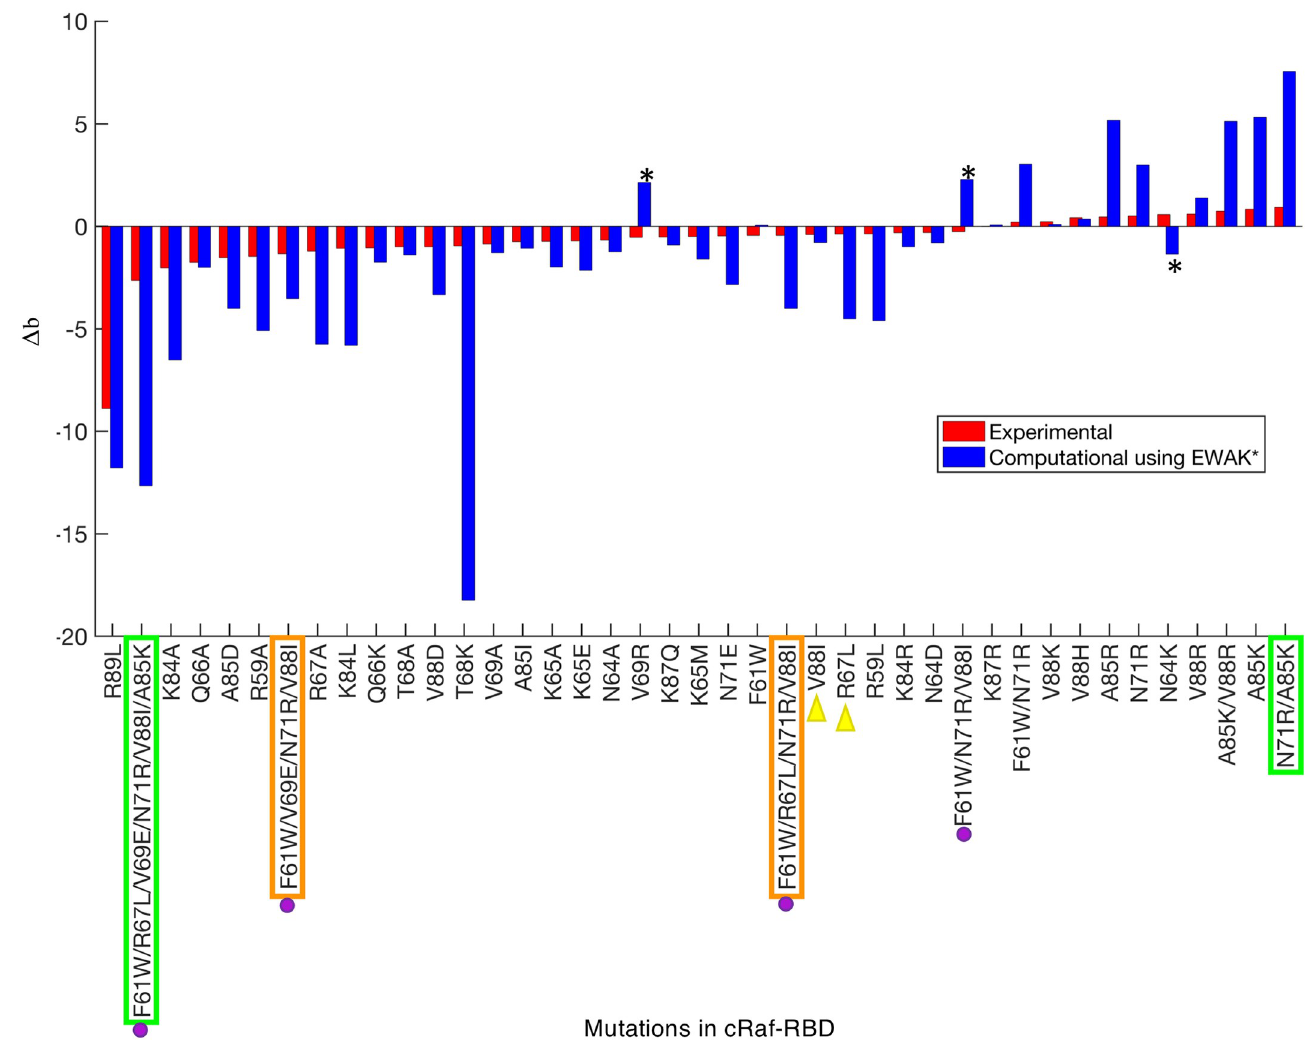
Fig 5. Predicting the effect of mutations in c-Raf-RBD on binding with KRas. Each bar represents either the experimental (red) or computationally predicted (blue) effect each variant has on binding. The bars are sorted in increasing order of Δ b value (see the Section entitled “ FRIES / EWAK � retrospectively predicted the effect mutations in c-Raf-RBD have on binding to KRas”) of the experimental (red) bars. If the Δ b value is less than 0, binding decreases. If the Δ b value is greater than 0, binding increases. If the Δ b value is close to 0, the effect is neutral. Quantitative values of K � tend to overestimate the biological effects of mutations (leading to the much larger blue bars) due to the limited nature of the input model compared to a biologically accurate representation. However, K � in general does a good job ranking variants, as can be seen here in Fig 6, in [1], and in [38]. Out of the 41 variants listed on the x -axis, only 3 were predicted incorrectly (marked with black asterisks) by EWAK � . In terms of accuracy, BBK � performed very similarly to EWAK � , however, in 2 cases (marked with green boxes), BBK � ran out of memory and was unable to calculate a score. BBK � also did not return values for the 2 variants marked with orange boxes. The variants marked with purple dots were tested in [60] experimentally—not computationally—and decreased binding of c-Raf-RBD to KRas GTP was observed, which EWAK � was able to predict correctly. The two variants marked with yellow triangles were computationally predicted in [60] to improve binding of c-Raf-RBD to KRas GTP . However, the experimental validation in [60] showed that these variants exhibit decreased binding, which EWAK � accurately